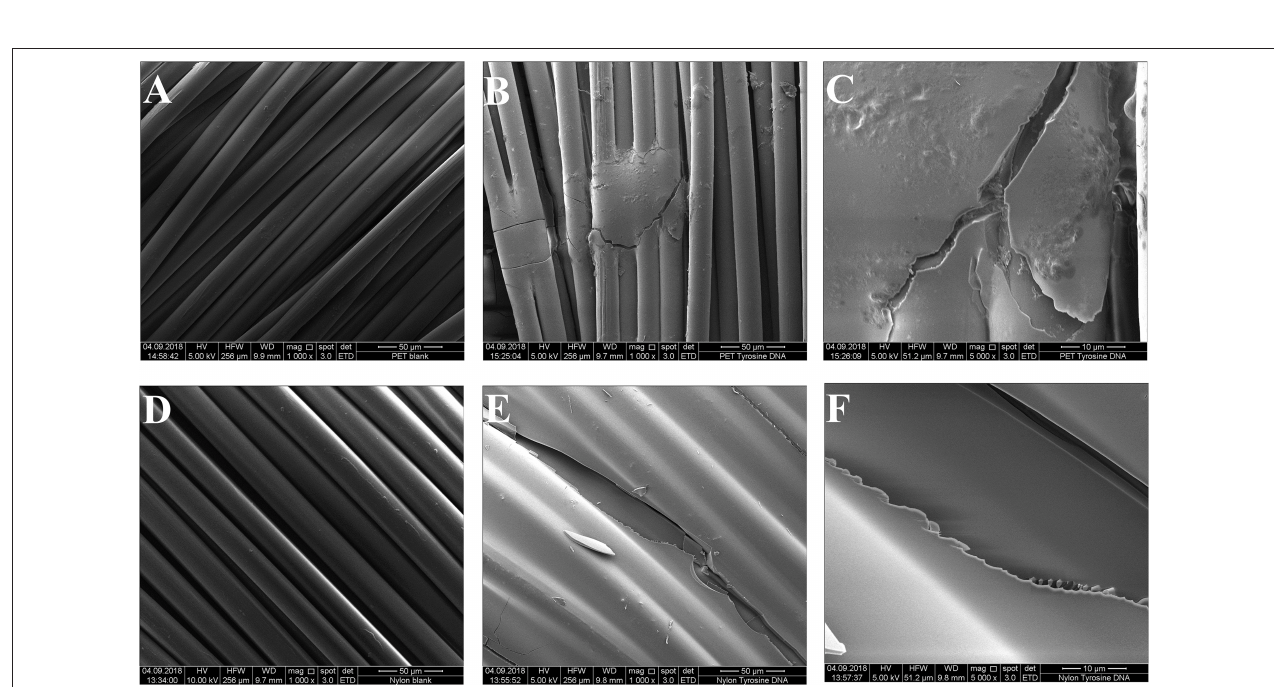
FIGURE 4 | FT-IR analysis of hydrolyzed nylon-6 after coating with tyrosine (blue line) and after tyrosine/DNA coupling (red line).